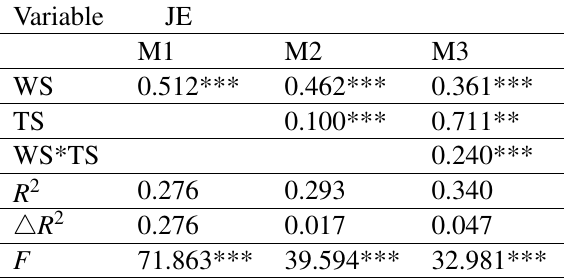
Table 10 The moderating effect of POS